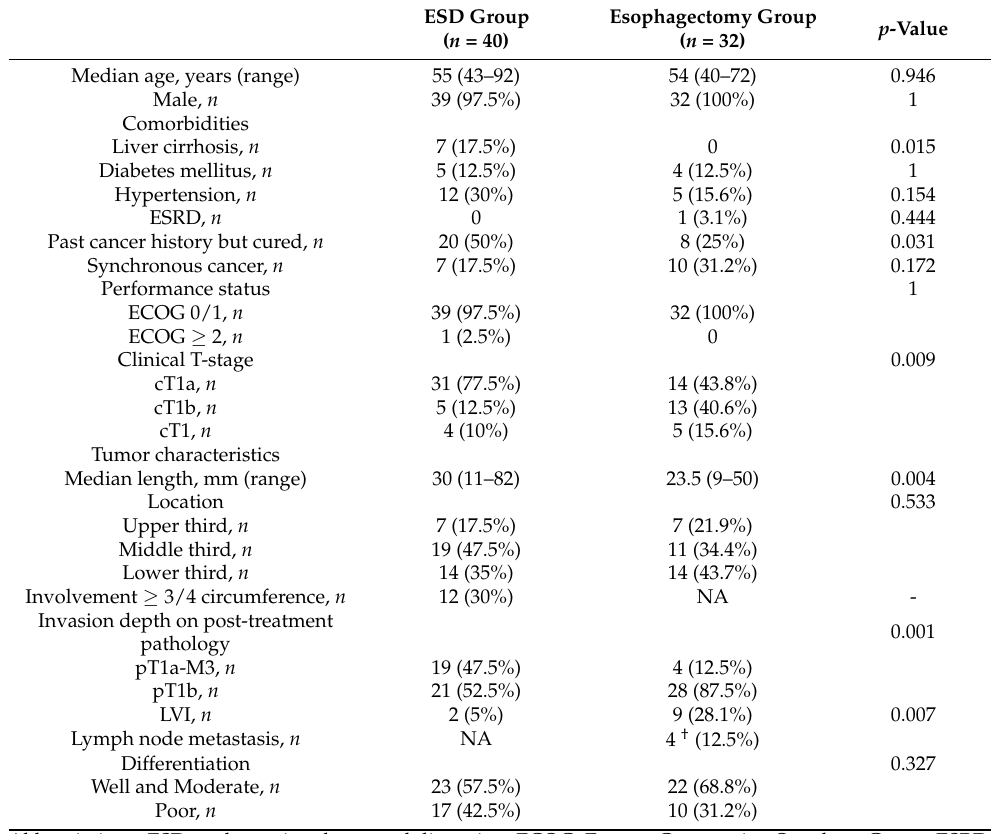
Table 1. Demographic data and tumor